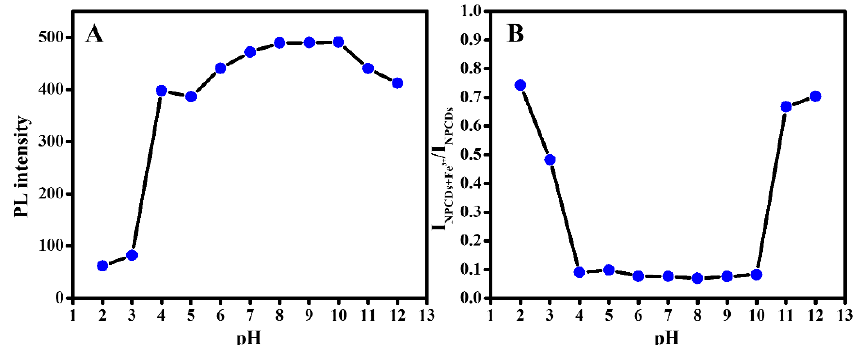
Figure 5. ( A ) Fluorescence intensity of NPCDs and ( B ) quenching effect of Fe 3+ on the fluorescence of NPCDs in a variety of pH values.